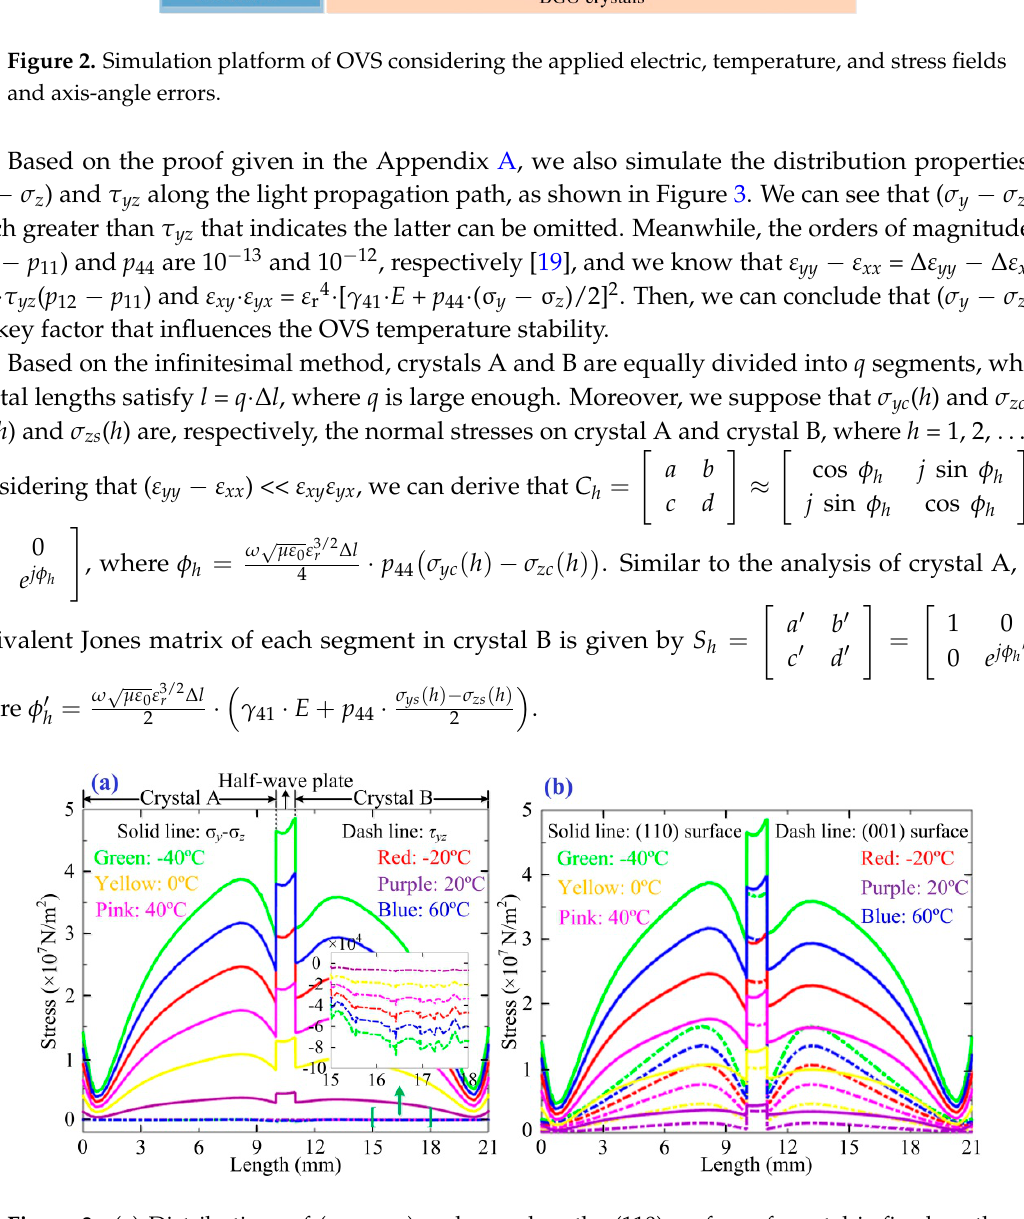
Figure 3. ( a ) Distributions of ( σ y − σ z ) and τ yz when the (110) surface of crystal is fixed on the mechanical device; ( b ) absolute values of ( σ y − σ z ) for the two different fixed methods under six different temperatures.